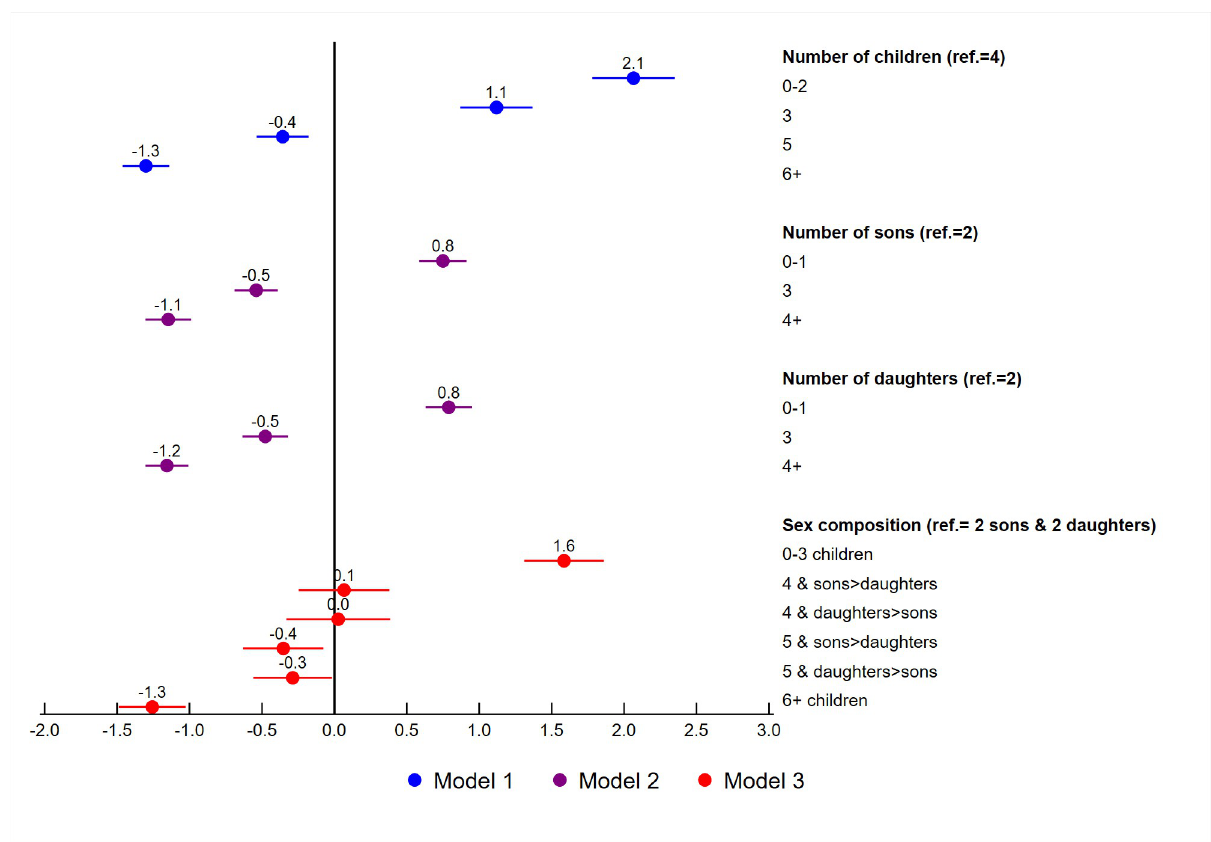
Fig 5. Adjusted regression coefficients for the fertility variables among women age 44–48, Western and Central Africa.